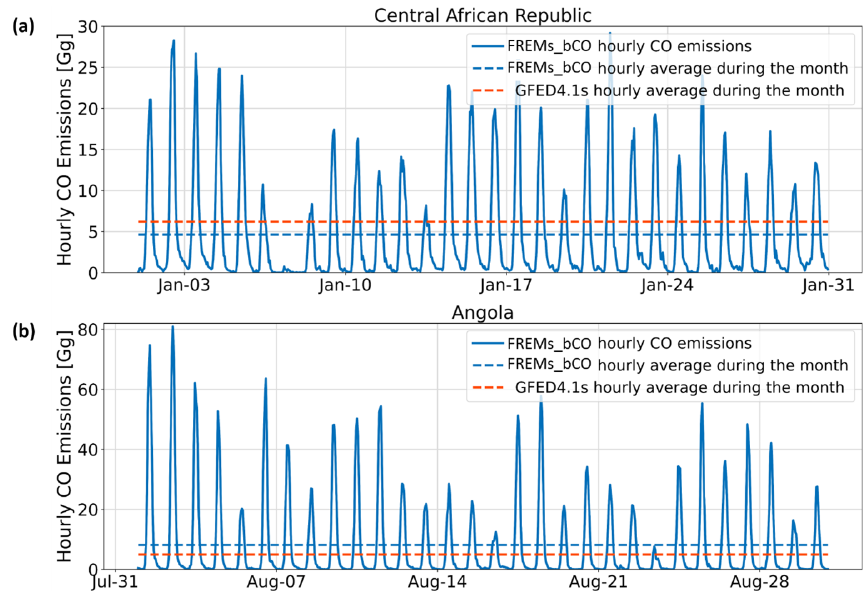
Figure 4. Hourly FREMs_bCO emissions from landscape fires burning over a month-long period in 2012 during the peak fire season of (a) the Central African Republic and (b) Angola. The monthly mean of this emission rate is also shown, along with that from GFEDv4.1s.